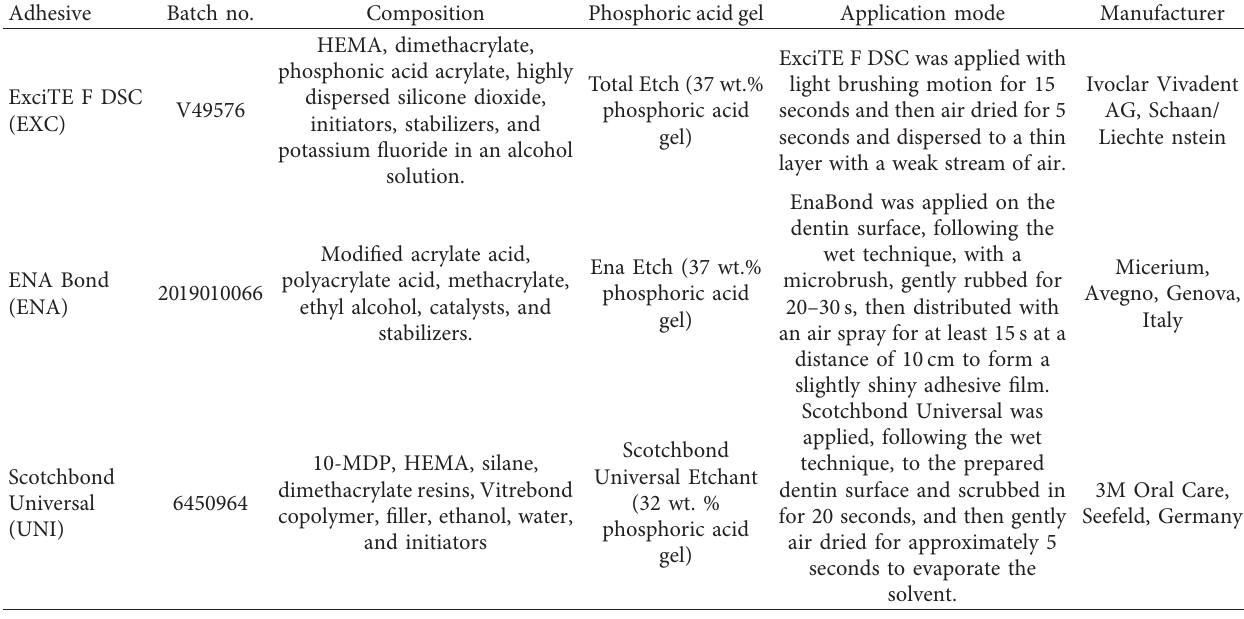
Table 1: Manufacturer, composition, and application mode of the adhesive systems tested. Adhesive